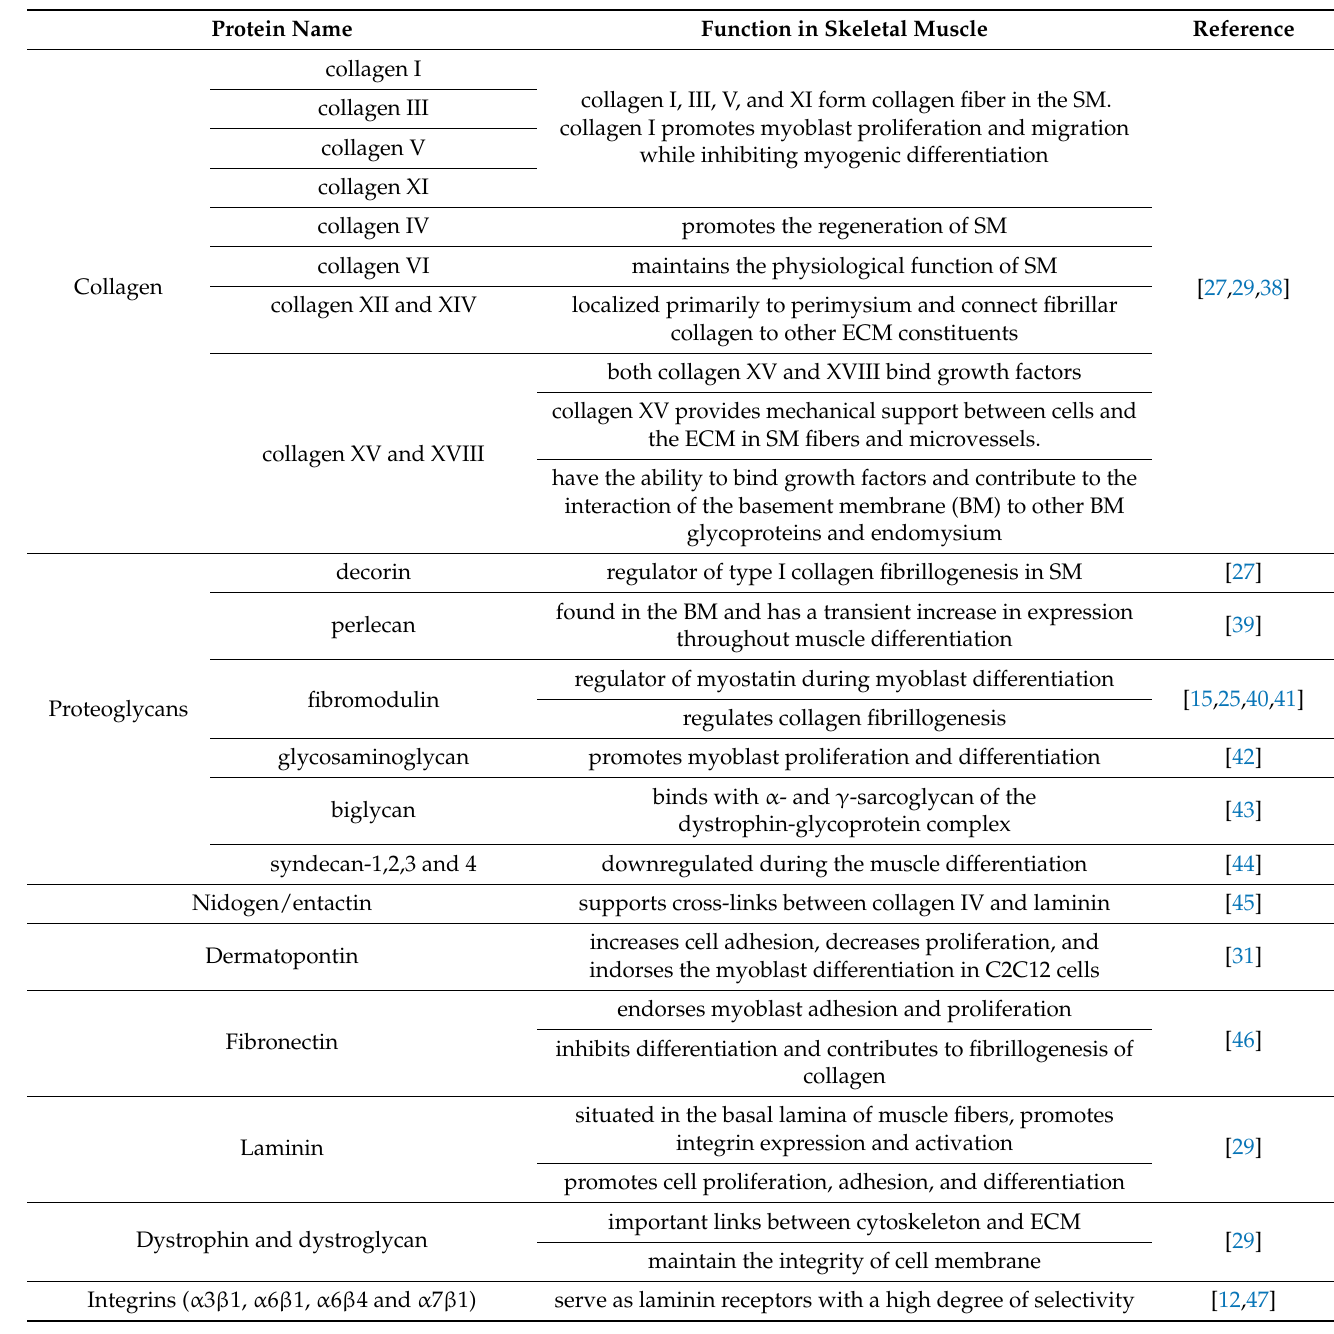
Table 1. ECM components and related proteins in skeletal